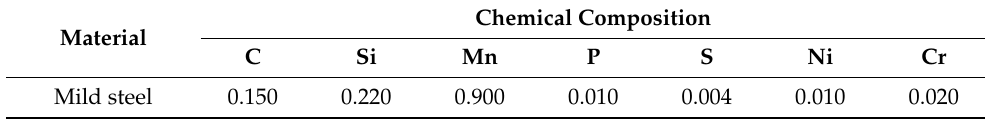
Table 1. Chemical compositions (wt.) of selected mild steel.